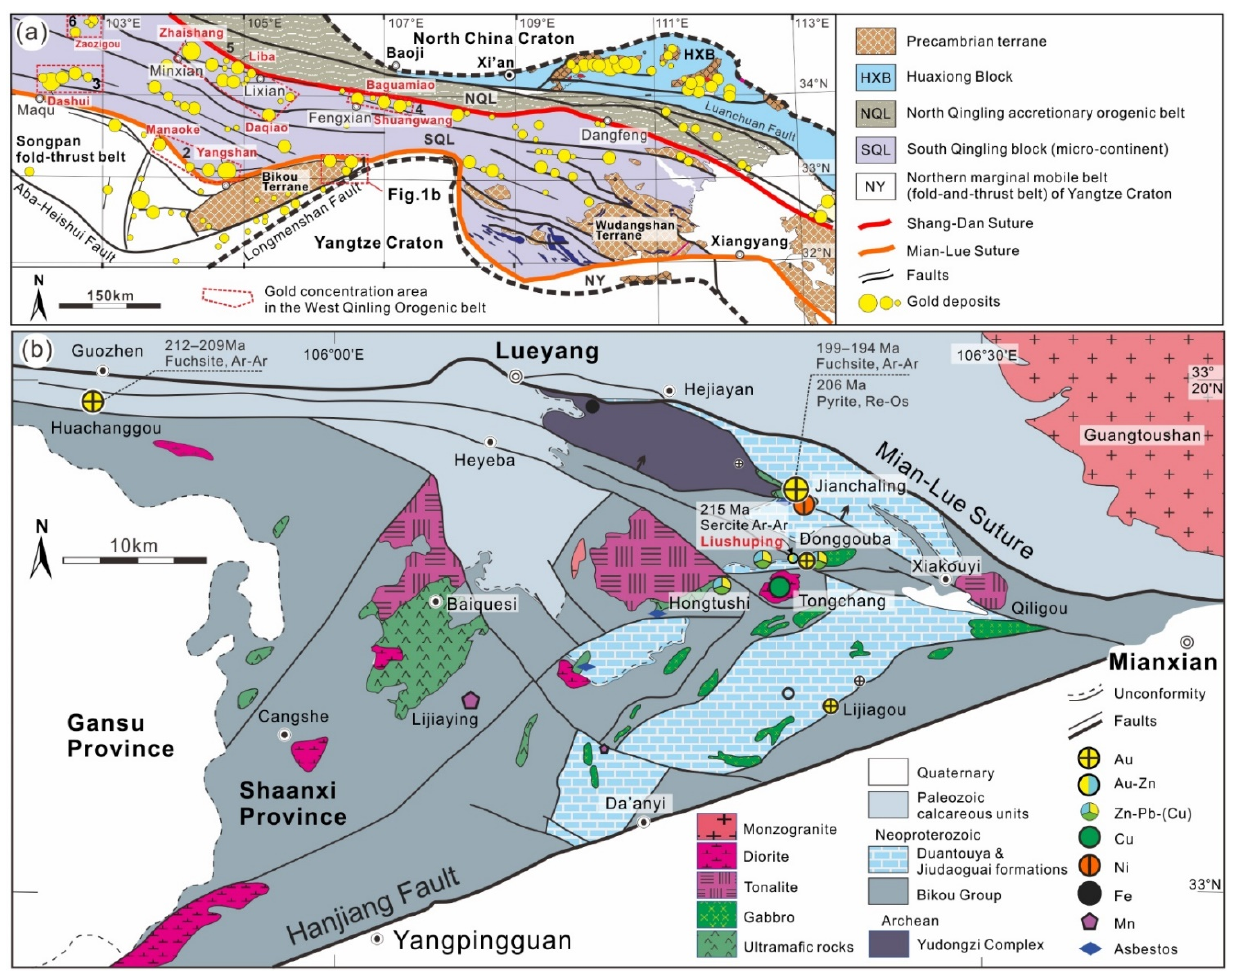
Figure 1. Maps of the: ( a ) tectonic subdivision of the Qinling Orogen, showing the location of the Mianxian–Lueyang–Yangpingguan area (modified after [2]); ( b ) regional geology and location of the Au deposits in the Mianxian–Lueyang–Yangpingguan area, showing the location of